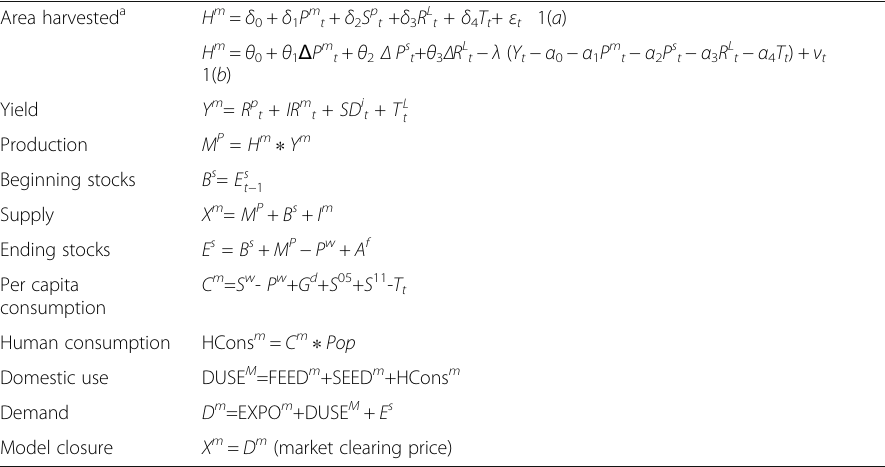
Table 3 Maize model